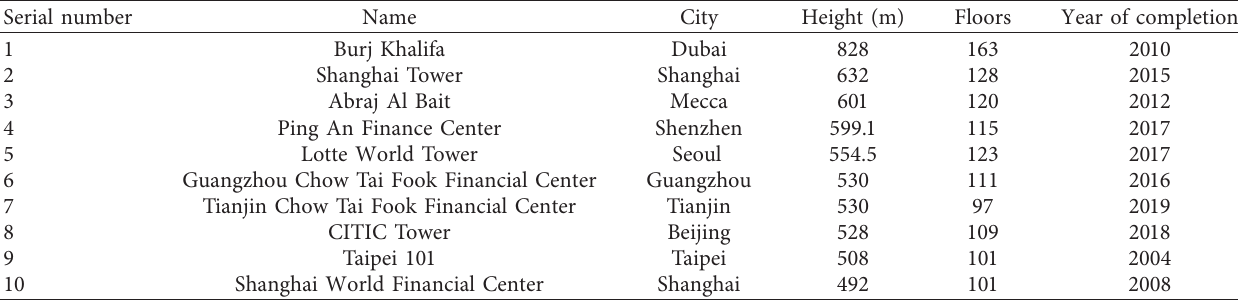
Table 1: The World’s top 20 super high-rise buildings (as of June 2021).